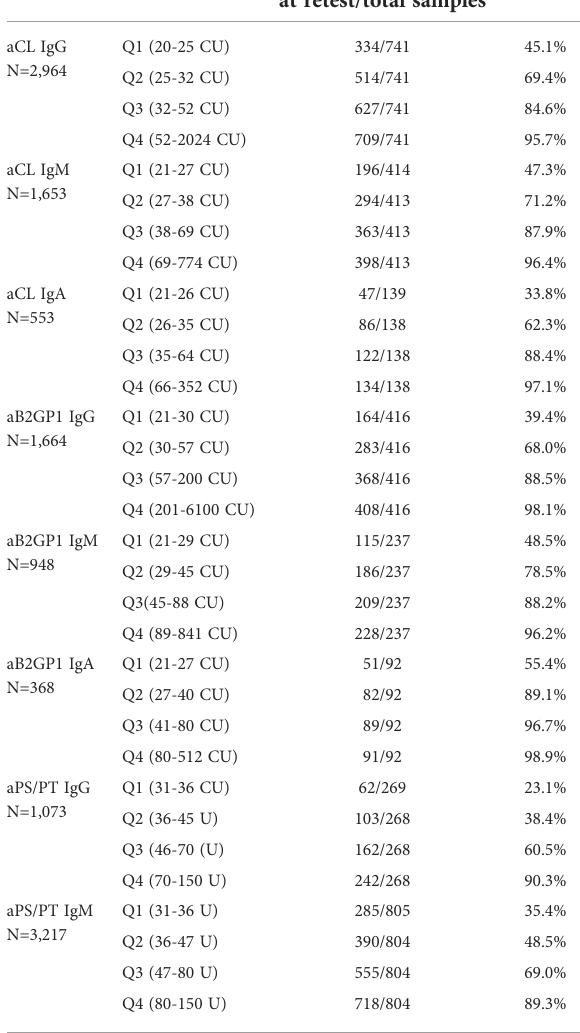
TABLE 1 aPL positivity at